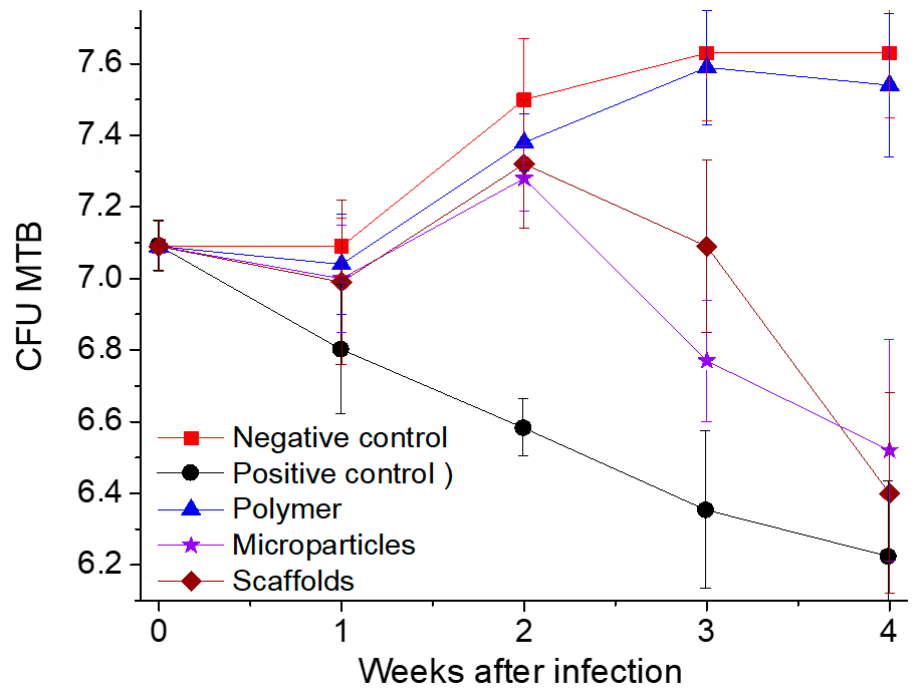
Figure 9. Time dependence of Mtb CFU/lung for different groups of mice.